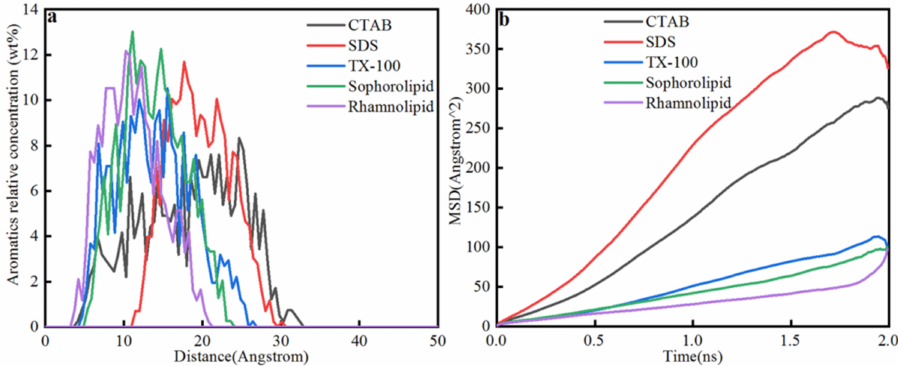
Figure 12. ( a ) Aromatics relative concentration; ( b ) Mean square